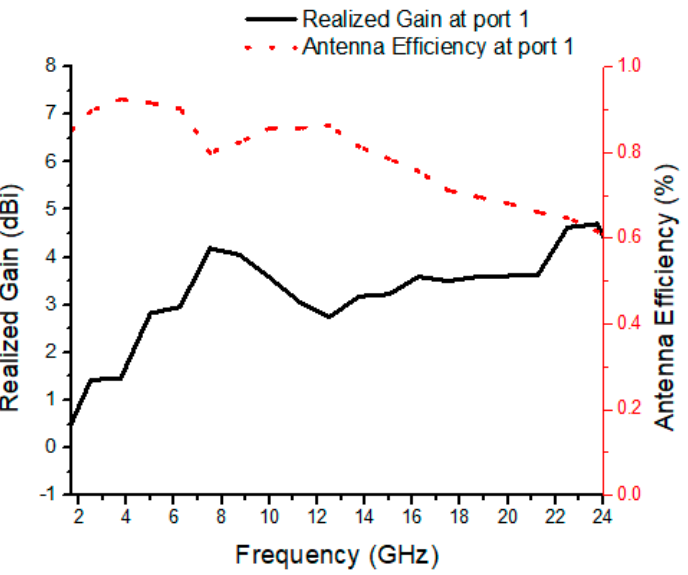
Figure 11. Measured and simulated S-parameters of the proposed MIMO antenna with respect to port1. ( a ) S-parameters and ( b ) isolation.